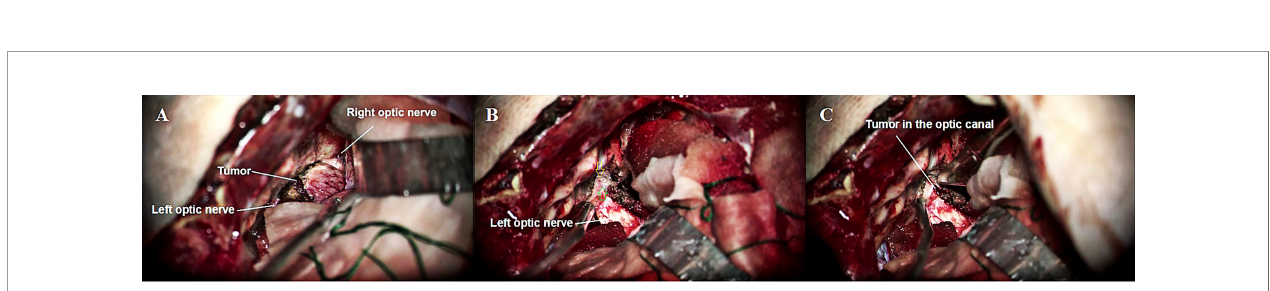
FIGURE 3 | It is the preoperative and postoperative MRI enhancement fi gure of one case. (A) and (B) showed the tumor was huge and surrounded bilateral internal carotid arteries. (C) and (D) showed total resection of the tumor.